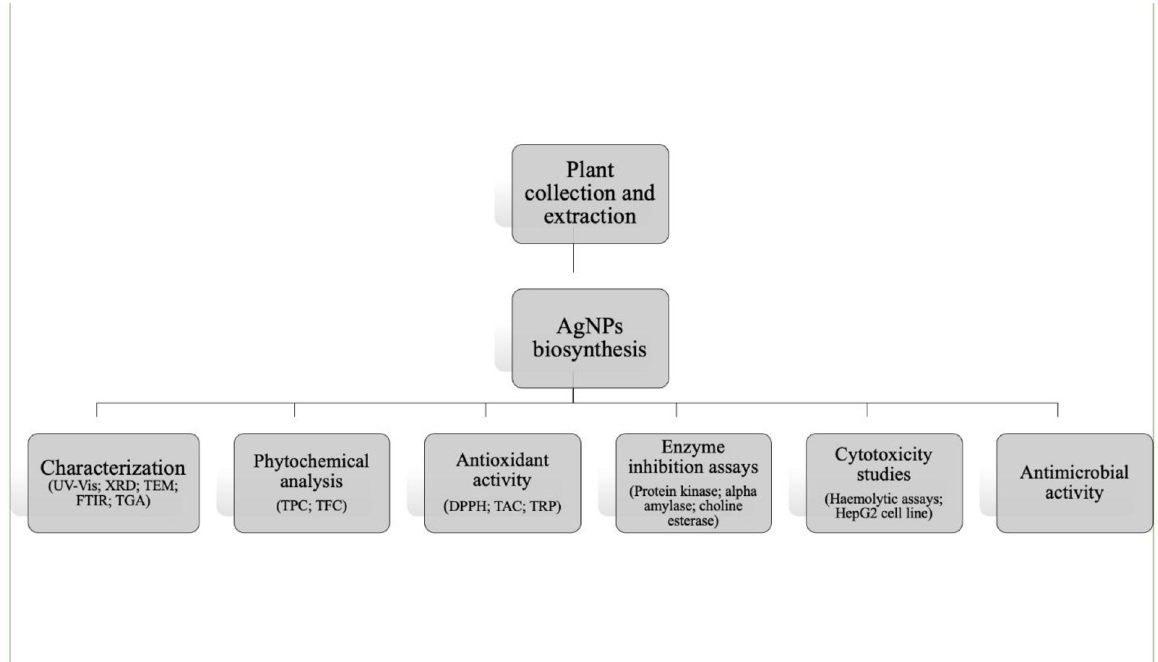
Fig 1. Schematic diagram of experiments